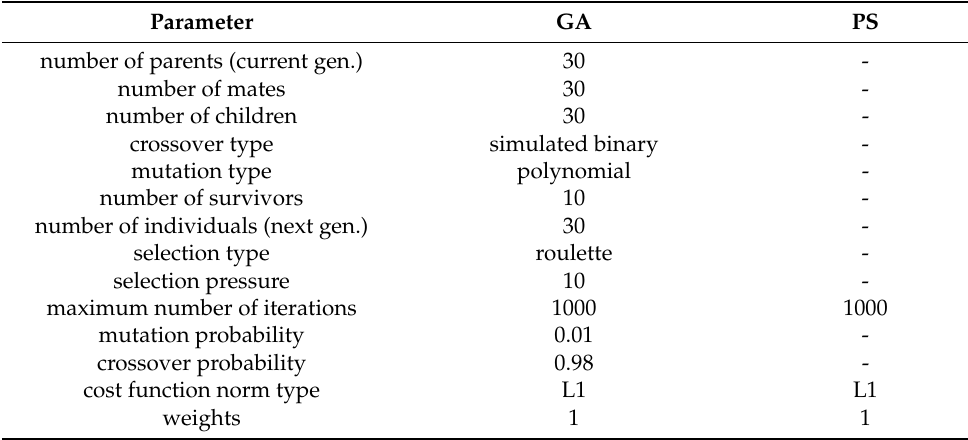
Table 4. HFSS optimizer options for Genetic Algorithm and Pattern Search.